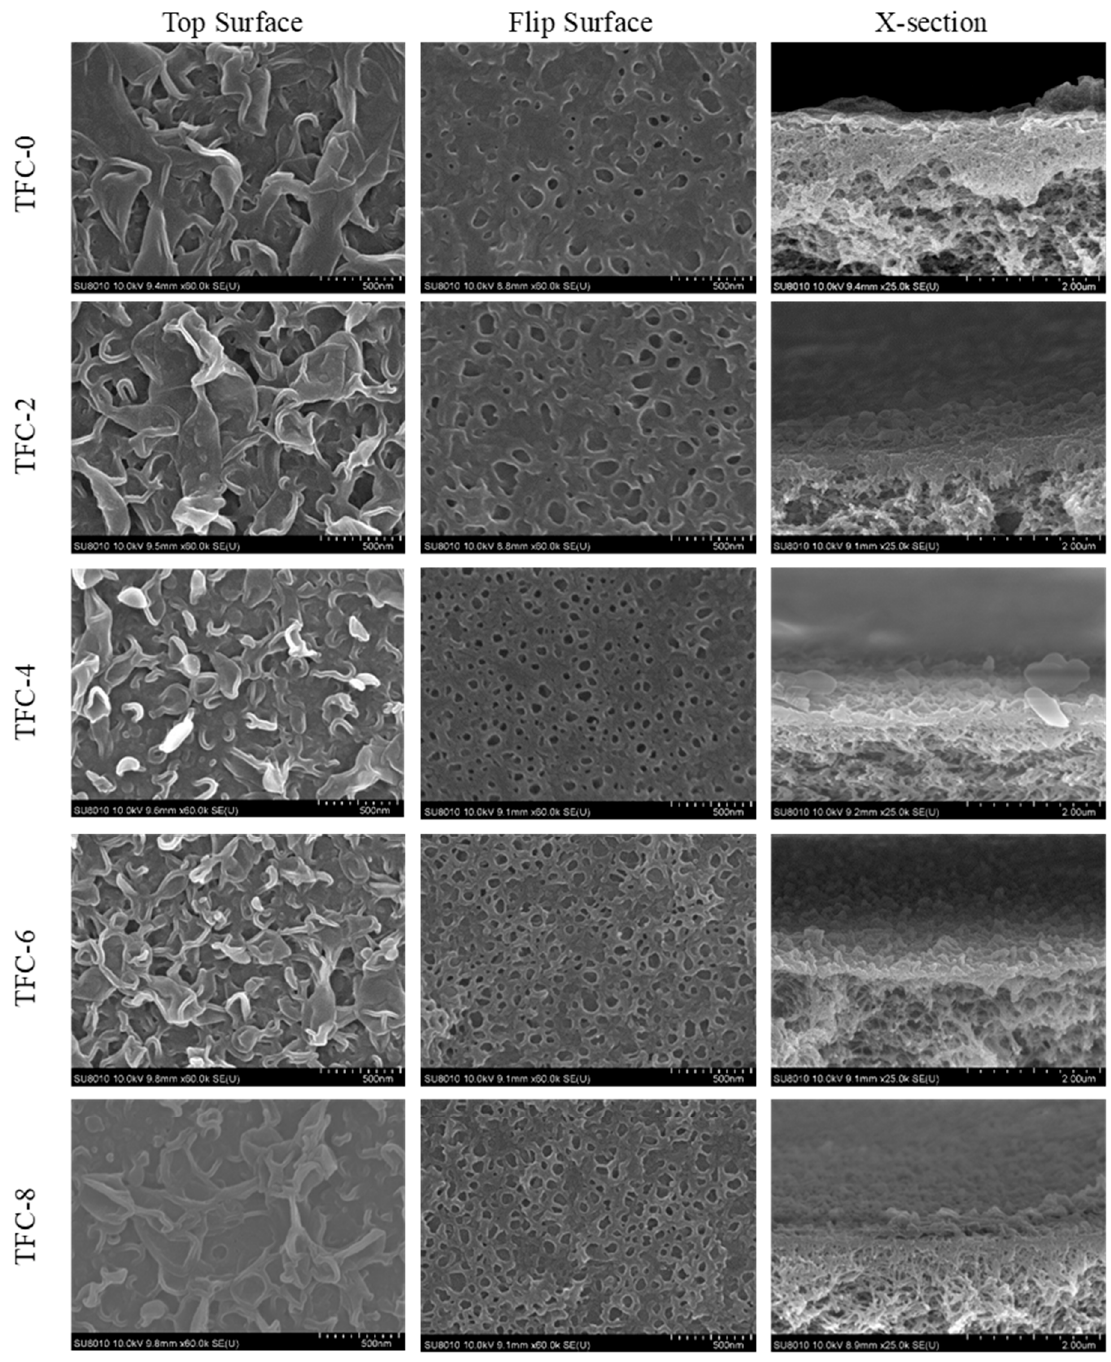
Figure 2. The top surface, flip surface, and cross-section SEM images of the FO